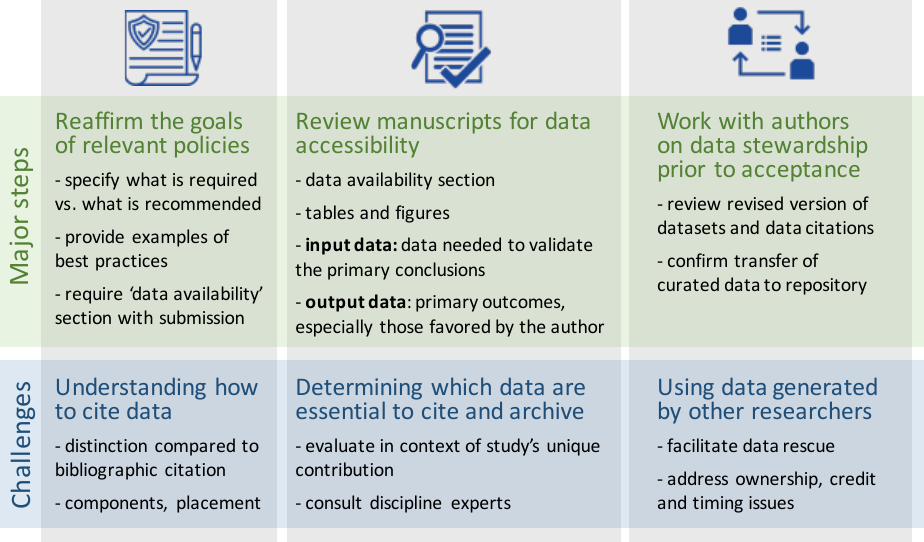
2 Procedure for implementing the open-paleo-data